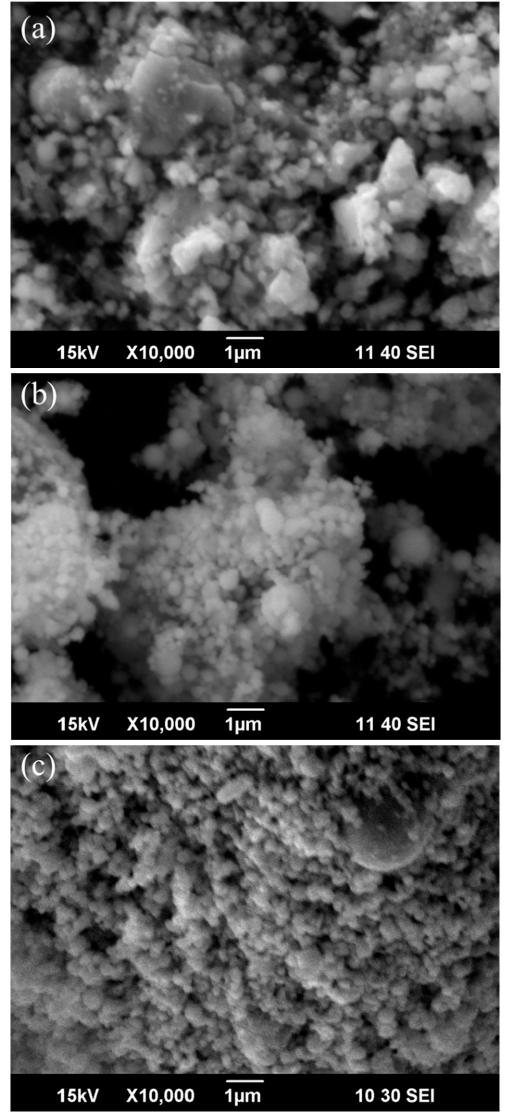
Figure 2. SEM micrographs of the three BOS filter cakes. ( a ) BOS-1; ( b ) BOS-2; ( c ) BOS-3.